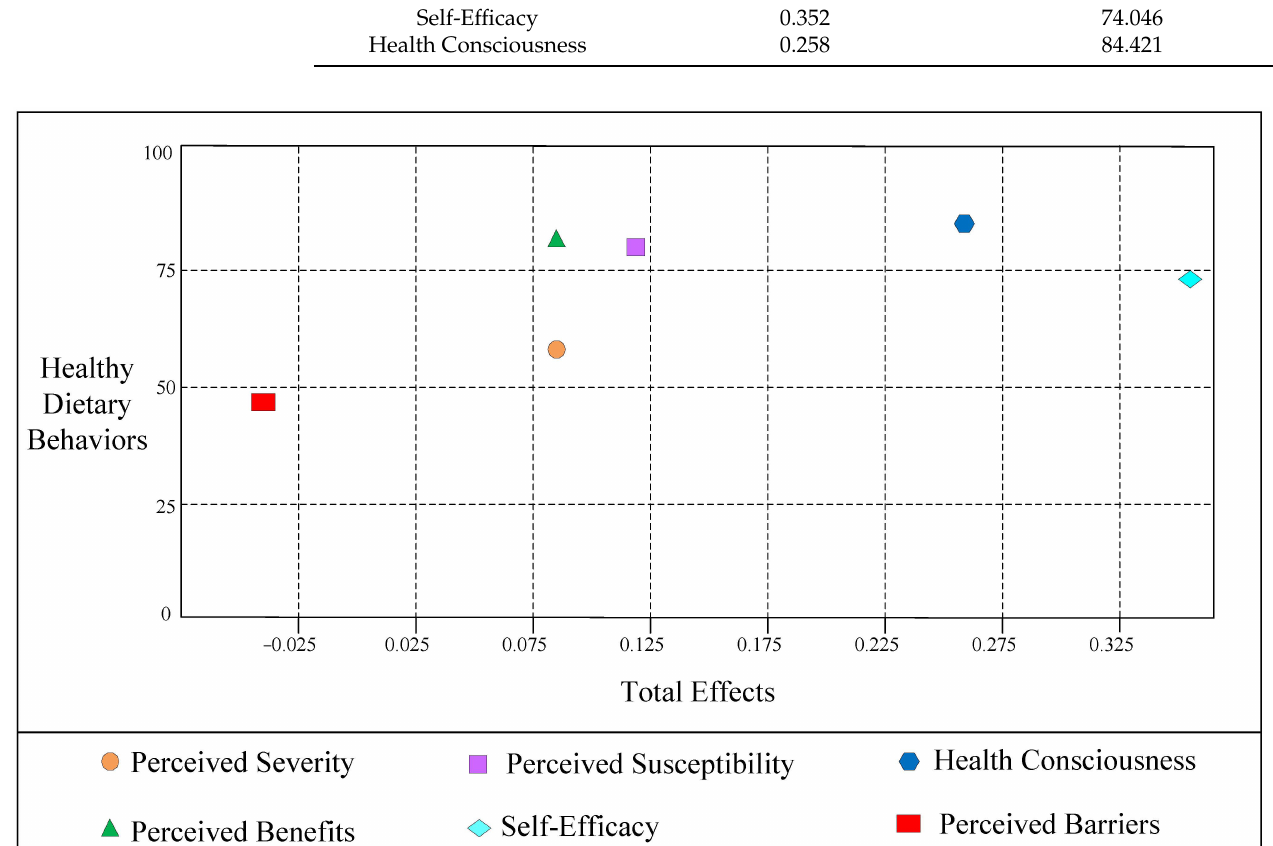
Figure 3. Importance performance